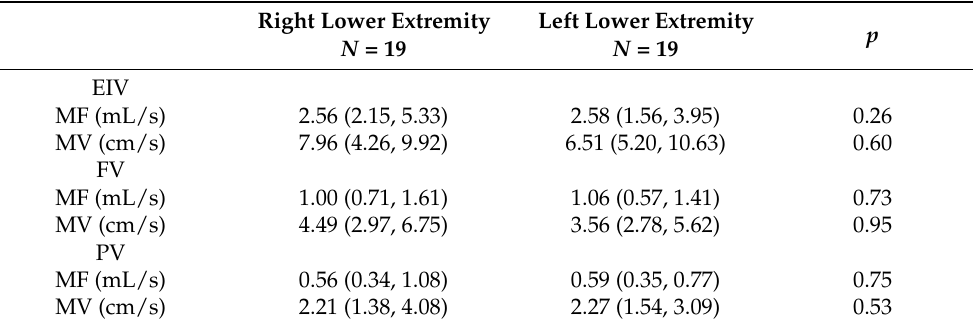
Table 2. Analysis of the bilateral lower extremities of patients without common iliac venous com- pression and deep vein